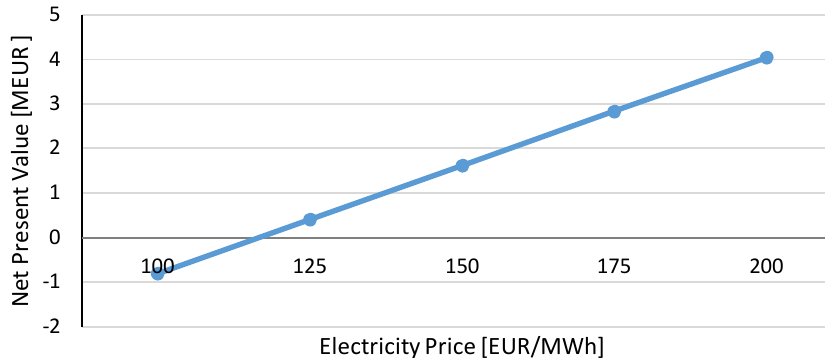
Figure 9. Electricity price influence on Net Present Value.